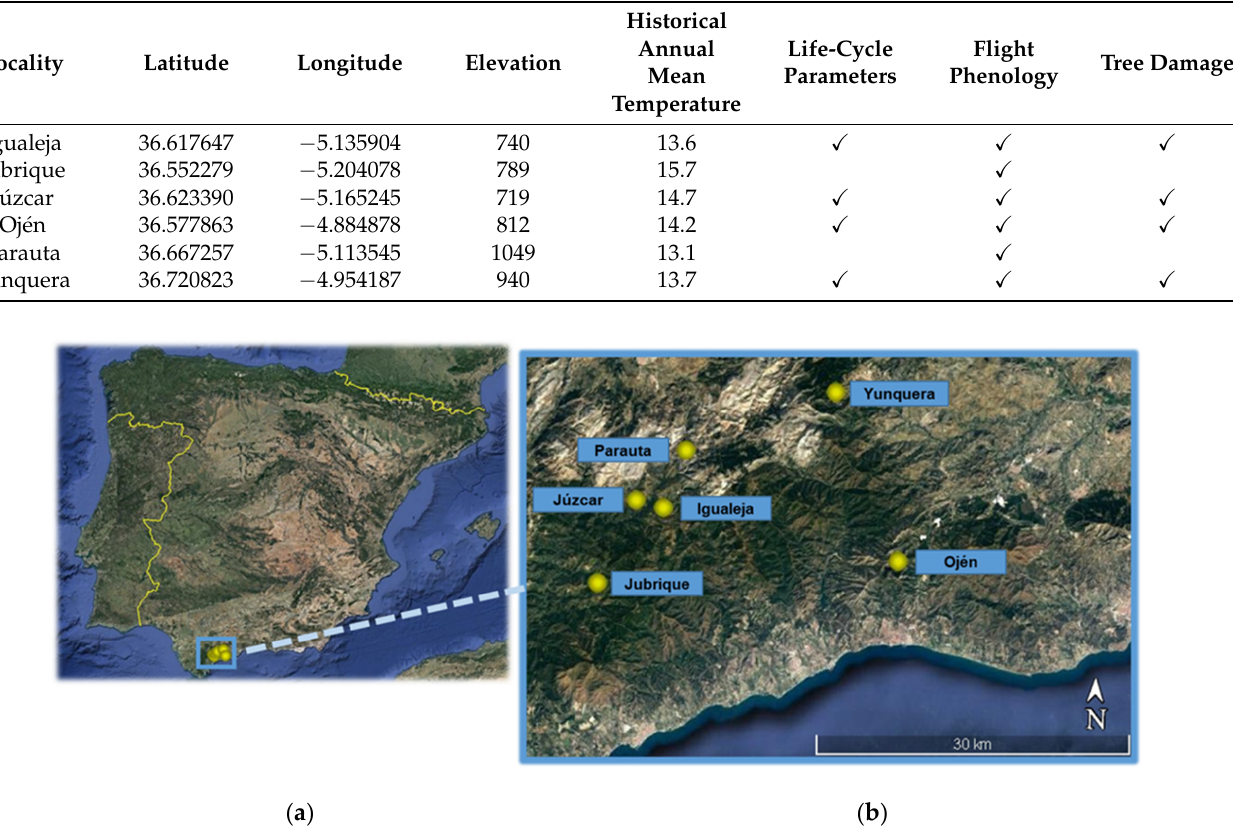
Figure 1. Orthoimage showing the location of the six sampled chestnut orchards in southern Spain (a) and within the province of Málaga (b).